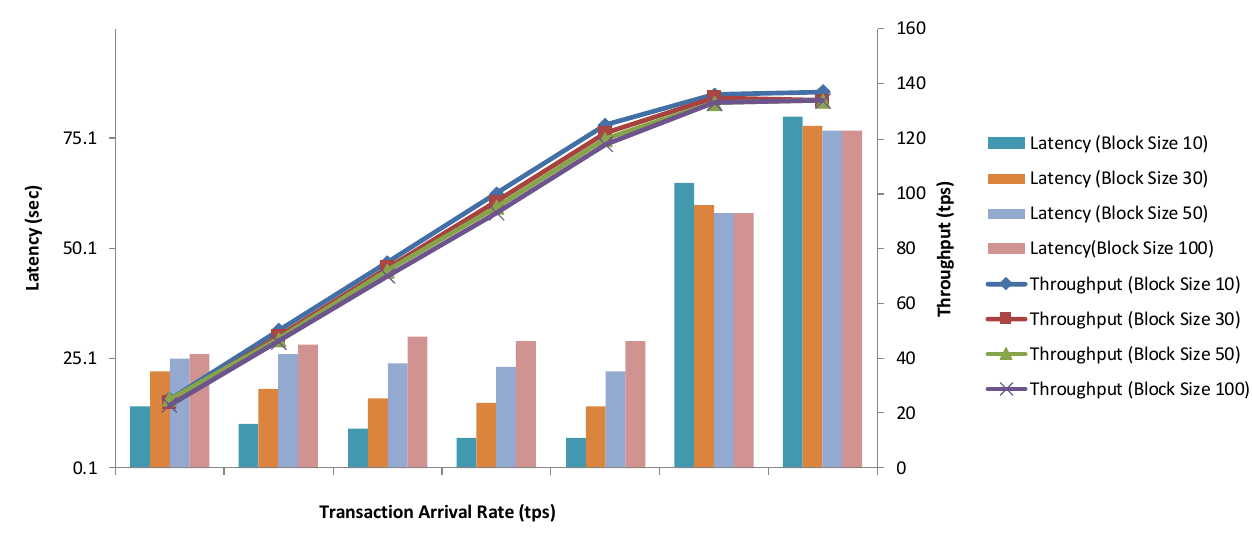
Figure 5. Performance of enhanced Fabric transactions with different block sizes.